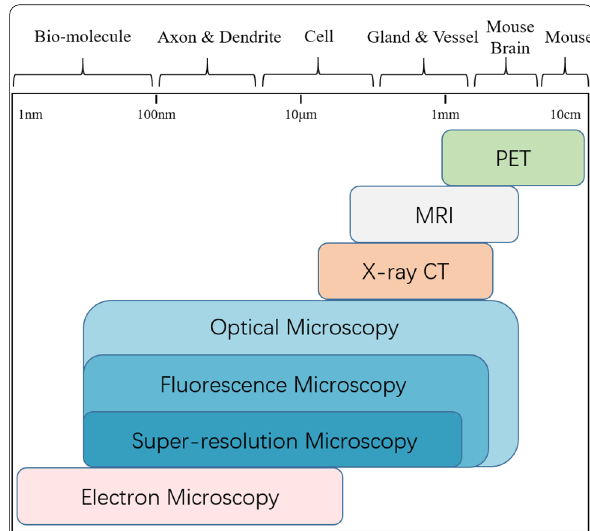
Table 1 Milestone innovations of imaging techniques